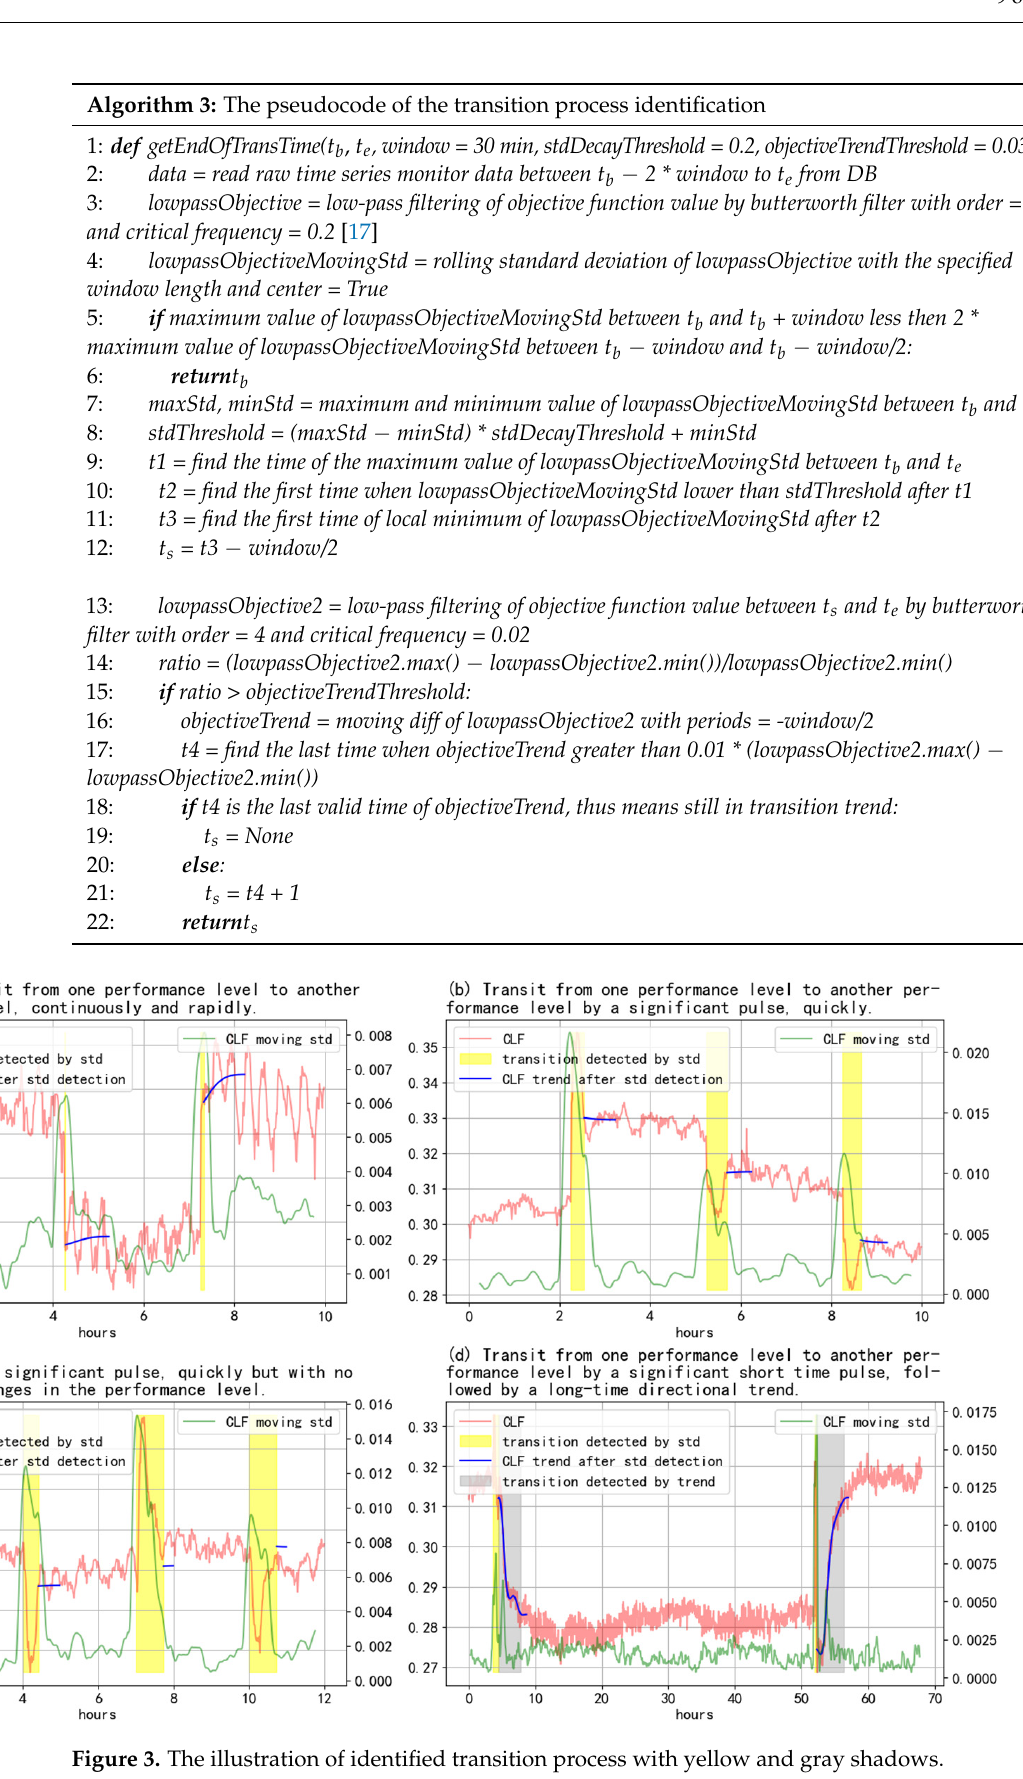
Figure 3. The illustration of identified transition process with yellow and gray shadows.